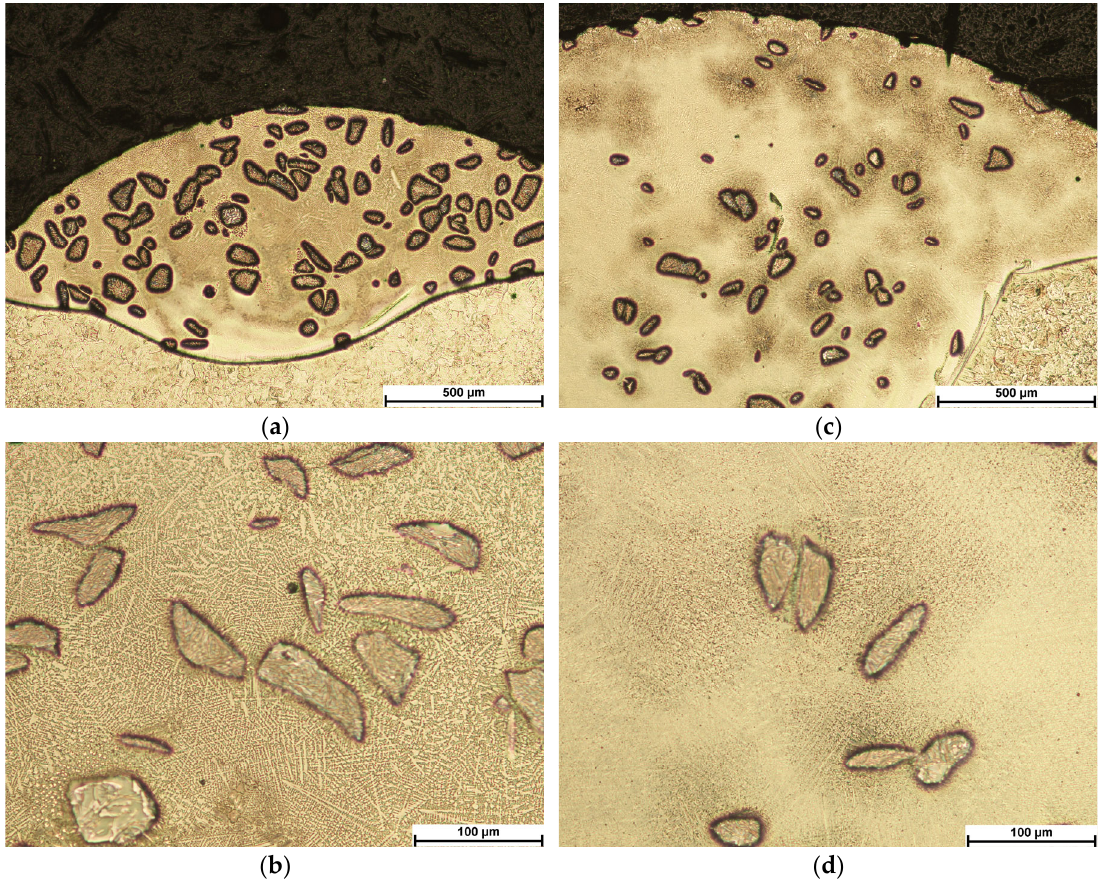
Figure 7. Microstructure of the comparative stringer beads LC2 and LC4 produced by laser cladding of experimental composite NiCrBSi/WC + W 2 C powder; ( a , b ) view of the entire single clad and the middle region respectively (laser output power 1.0 kW, scanning speed 300 mm/min, energy input 120 J/mm); and ( c , d ) view of the entire clad layer and the middle region of the clad respectively (laser output power 2.0 kW, scanning speed 300 mm/min, energy input 240 J/mm).